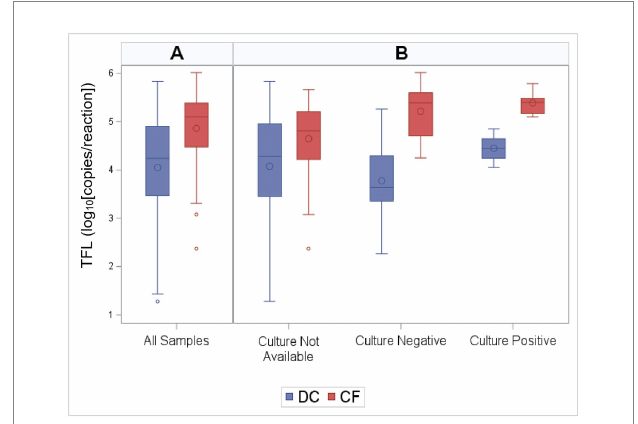
Supplementary Table 1. CF samples exhibited increased frequency of